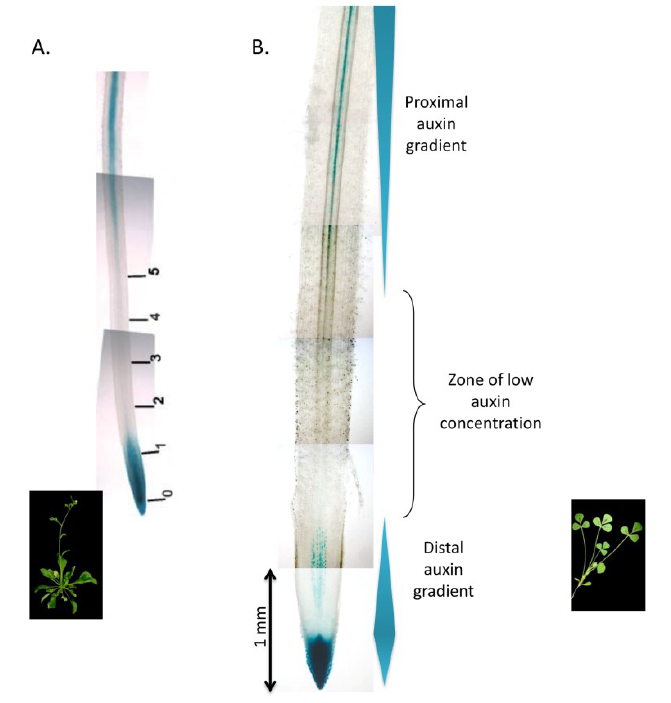
Figure 2. DR5:GUS reporter gene activity reflecting auxin gradients in M. truncatula and A. thaliana primary roots. ( A ) DR5:GUS expression gradient in Arabidopsis, as described in [55]; ( B ) DR5:GUS expression gradient in M. truncatula [63]. GUS activity appears in